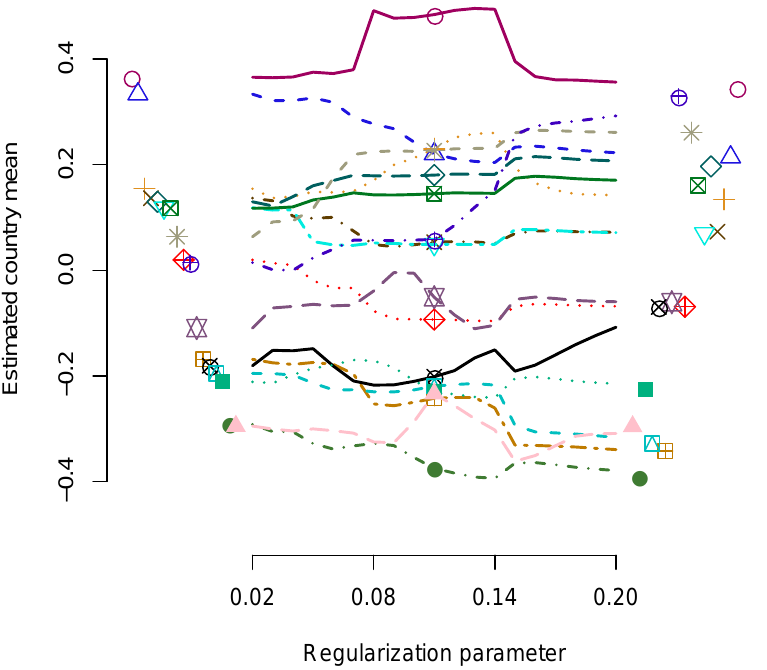
Figure 3. Empirical example: Regularization paths for estimated country means in regularized maximum likelihood estimation as a function of the regularization parameter κ ν